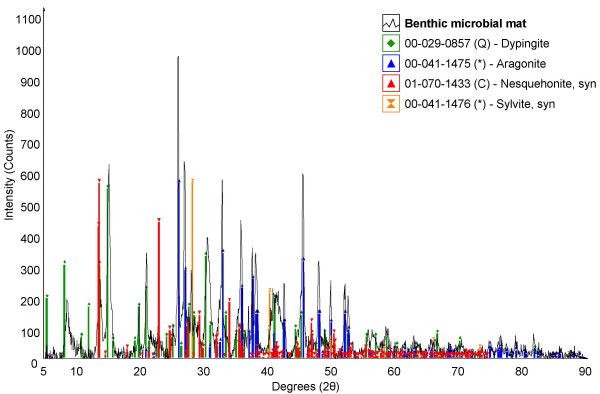
Powder X-ray diffraction pattern of minerals in the natural benthic mat. The plot is of X-ray beam intensity (background subtracted) versus 2θ and ICDD data for matching mineral phases are indicated by stick patterns.